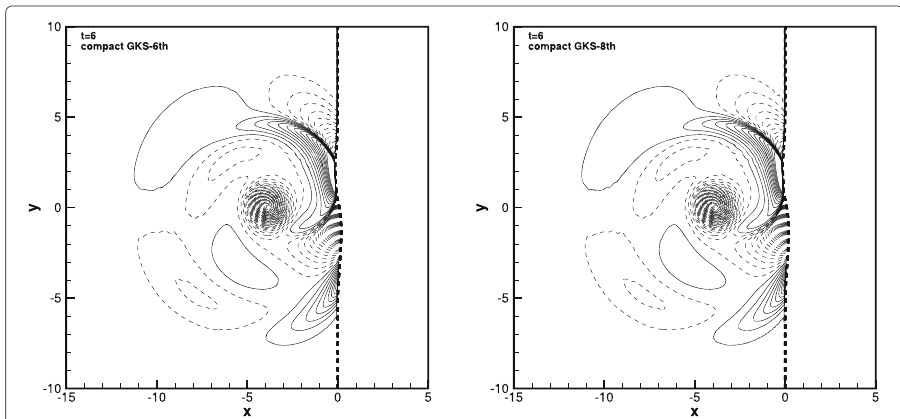
Fig. 19 Two-dimensional acoustic problem: sound pressure contours obtained by 6th-order and 8th-order compact GKS at t = 6 with 700 × 600 mesh points. Shock and vortex Mach numbers are M s = 1.2 and M v = 1. Here 150 equal-spaced sound pressure contours from − 0.5 to 0.05 are plotted. The dash line